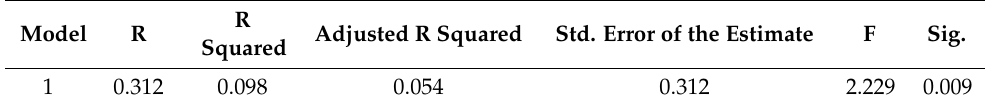
Table 6. Model summary (loss of sensitive